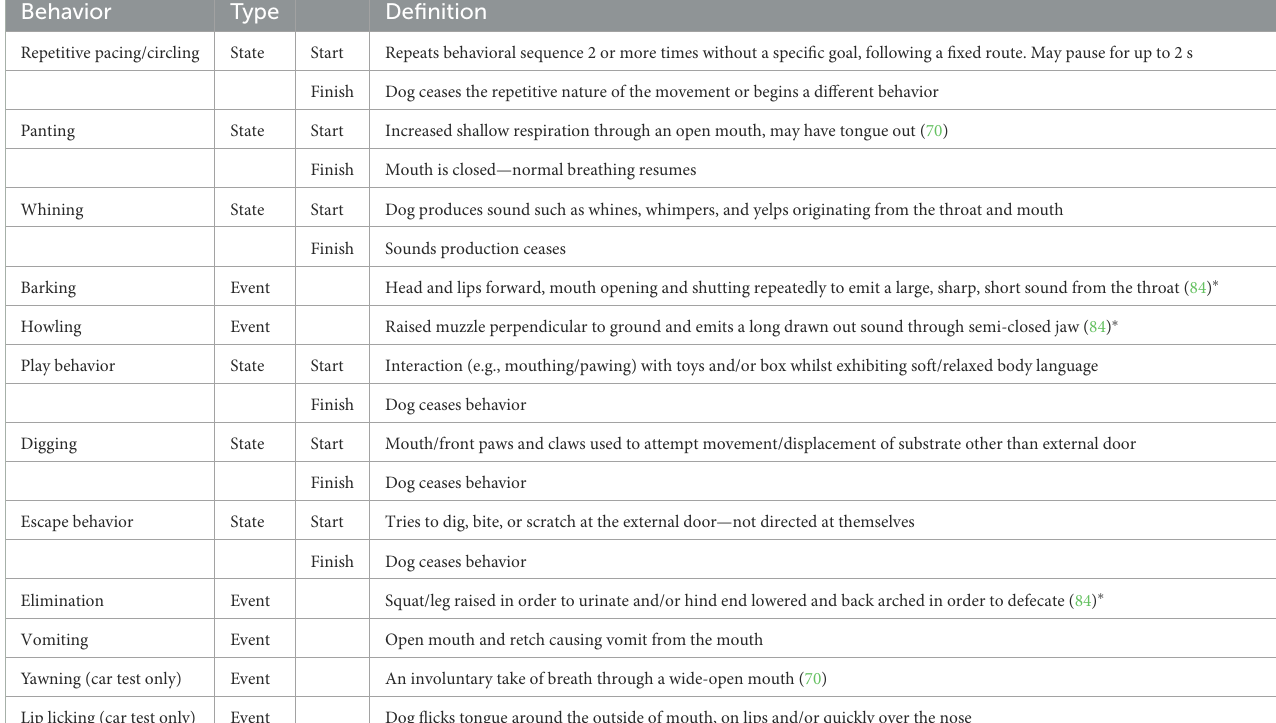
TABLE 2 Ethogram used to measure dog behavior during the separation and car travel tests. Behavior Type